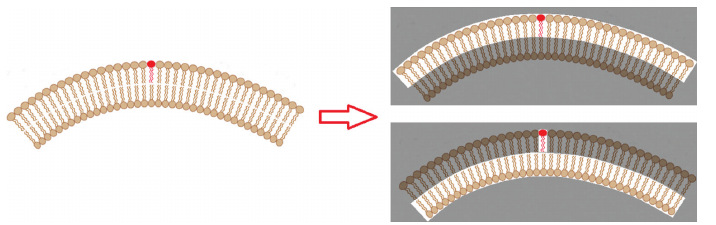
Figure 7 The nano bilayer molecule membrane.